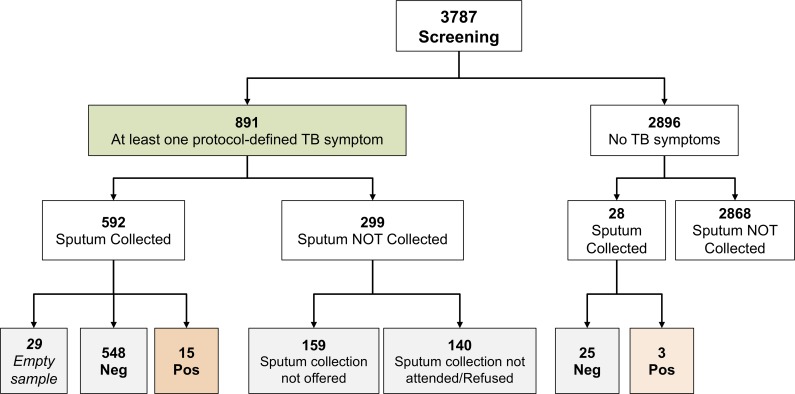
Study flow diagram.